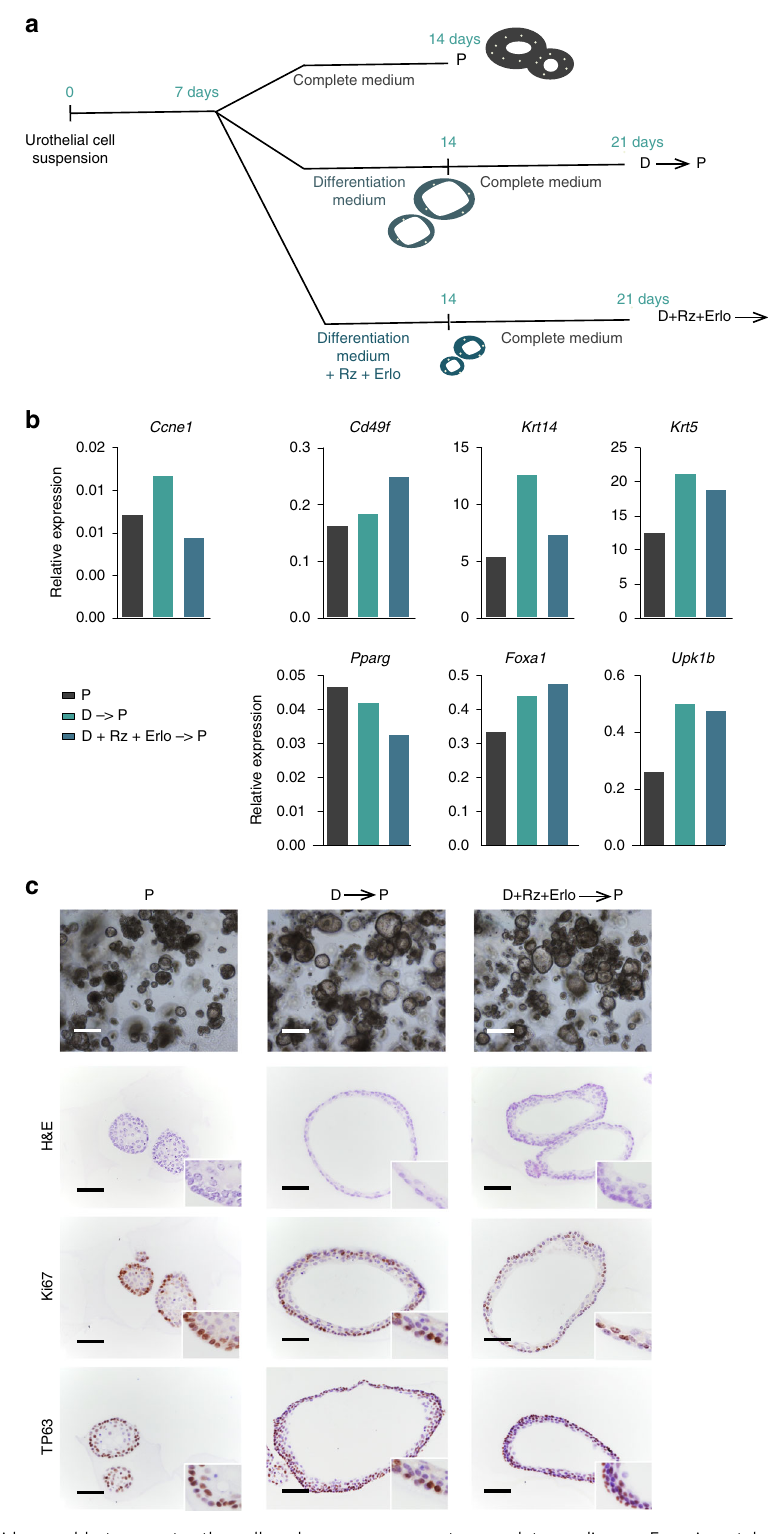
Fig. 5 Differentiated organoids are able to re-enter the cell cycle upon exposure to complete medium. a Experimental strategy: day 7 P organoids were maintained for 7 additional days either in complete medium (P), differentiation medium (D), or differentiation medium supplemented with Roziglitazone and Erlotinib (D + Rz + Erlo). D organoids were then switched to complete medium (D − P; D + Rz + Erlo − P) for 7 additional days. b RT – qPCR analysis of expression of genes regulated during differentiation. Data are normalized to Hprt expression ( n = 1 biological replicate). c Representative phase contrast images of organoid cultures (scale bar, 500 μ m), H&E staining, and immunohistochemistry for Ki67, TP63, and UPK3a ( n = 1 biological replicate) (scale bar, 250 μ m). Source data are provided as a Source Data fi